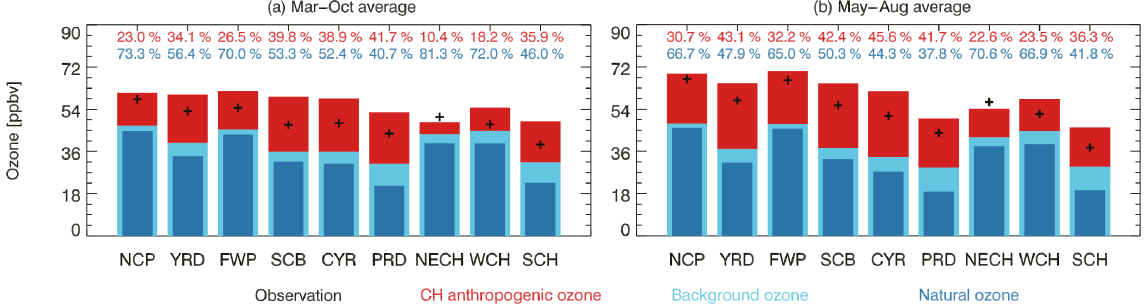
Figure 5. Simulated MDA8 ozone and the source attributions in nine city clusters in 2016–2017 averaged for (a) March to October and (b) May to August. The black pluses denote the observed mean ozone MDA8 values. The bars present simulated mean ozone MDA8 values, with the domestic anthropogenic ozone contribution in red, the background ozone contribution in light blue, and the natural sources in dark blue. The percentage of domestic anthropogenic contribution (red) and natural contribution (dark blue) for each cluster is